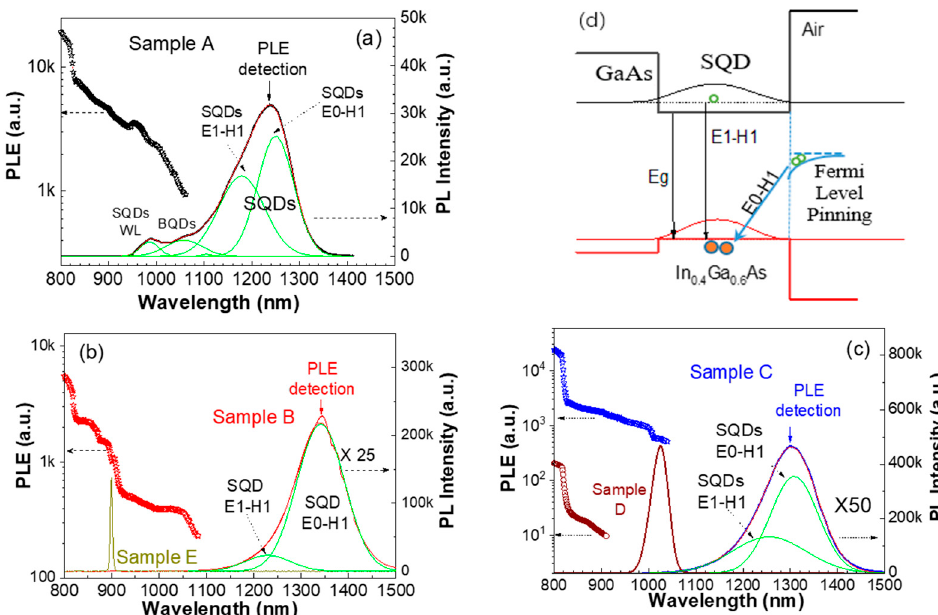
Figure 2. The PL and PLE characterization results. The PL and PLE spectra were measured at 10 K for: ( a ) sample A, ( b ) sample B and QW reference sample E, and ( c ) sample C and BQDs reference sample D. ( d ) Schematic band diagram showing the SQDs along with the surface states which result in indirect recombination.